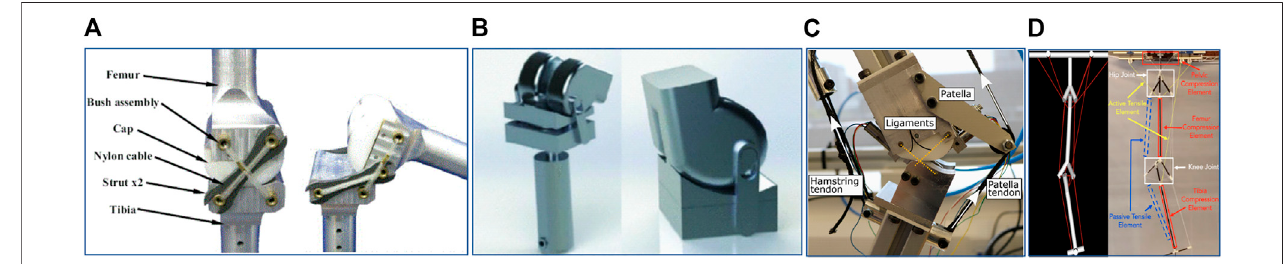
FIGURE3| Bio-inspiredkneejointbasedonbonestructure. (A) CondylarHingeJointbyEtoundietal.(2011) (B) KneejointforbipedalrobotbySteeleetal.(2017) (C) Biomimicking design for mechanical knee by Russell et al. (2018) (D) Tensegrity fl exural joints by Jung et al. (2018).